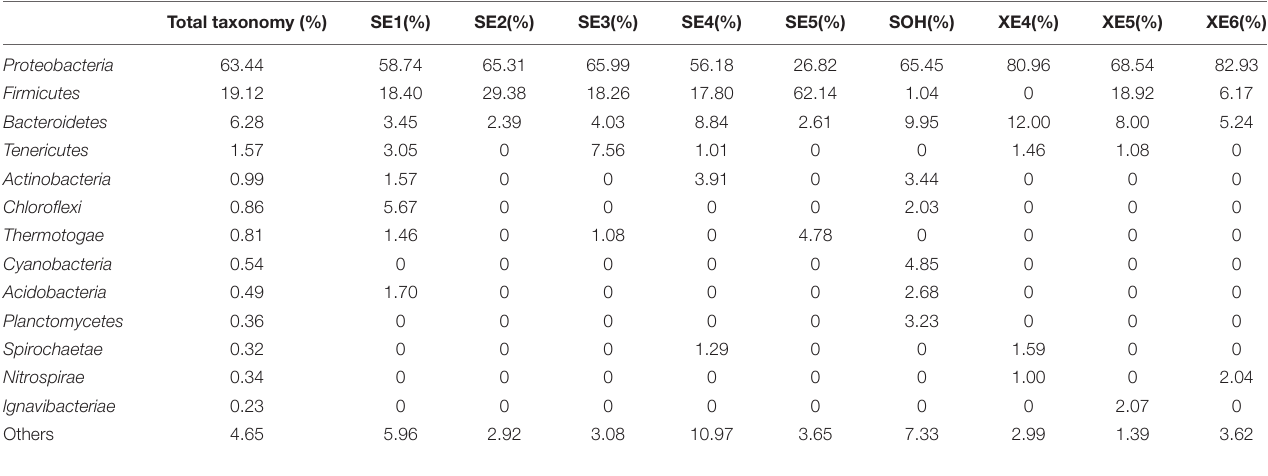
TABLE 2 | Microbial community compositions at phylum